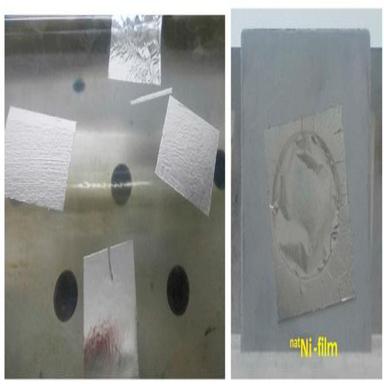
The floating film of self-supporting Ni and its target holder.